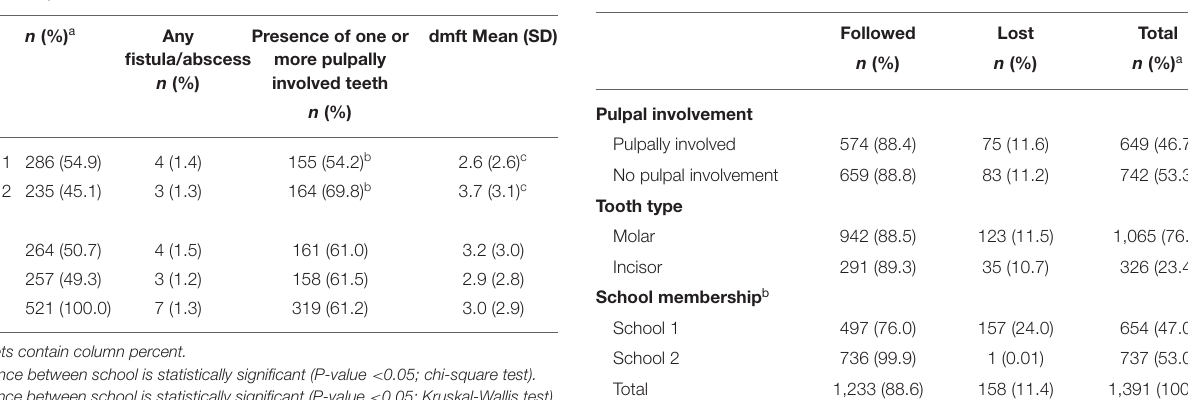
TABLE 4 | Attrition of teeth between baseline and 1-year follow-up by clinical